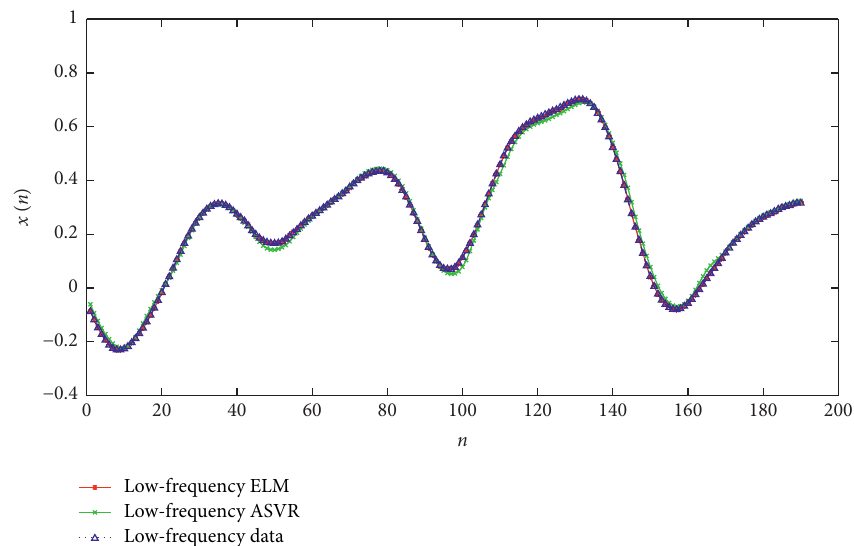
Figure 5: Prediction results of low-frequency sequence of data set A by ELM and ASVR